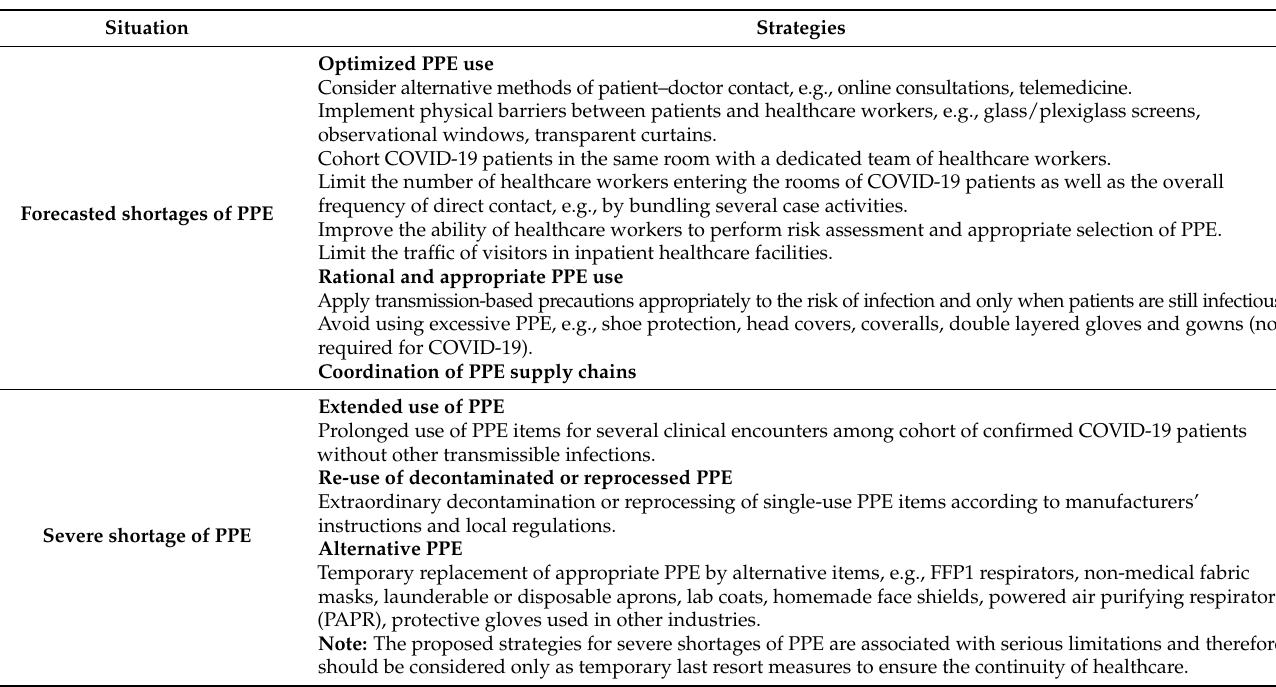
Table 1. Strategies for personal protective equipment shortages during COVID-19 pandemic recommended by the World Health Organization [36]. Situation Strategies